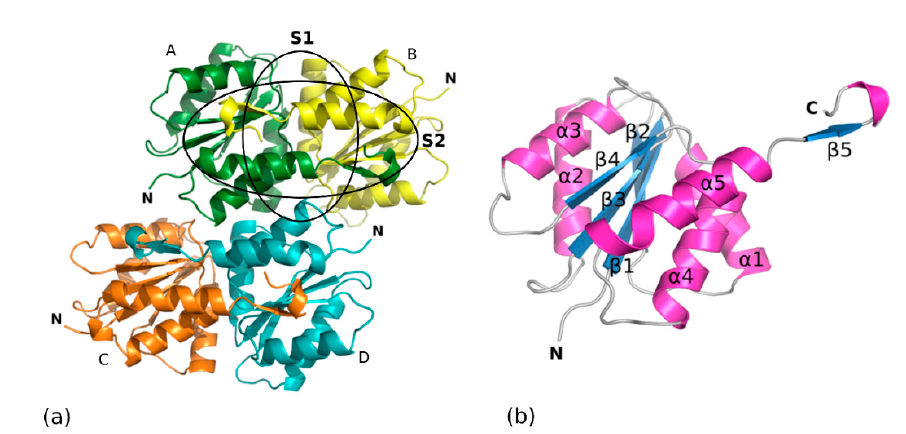
Figure 3. Cartoon representation of EIIA domain of mannose phosphotransferase system (SpEIIA-Man) from Streptococcus pneumoniae (PDB code: 6FMG). ( a ) Homotetramer present in the asymmetric unit. First dimer is colored in green and yellow and the second one is colored orange and blue. ( b ) Monomer with secondary elements numbered. Table 1. Crystallographic Data Collection and Refinement Statistics. Data collection and processing.